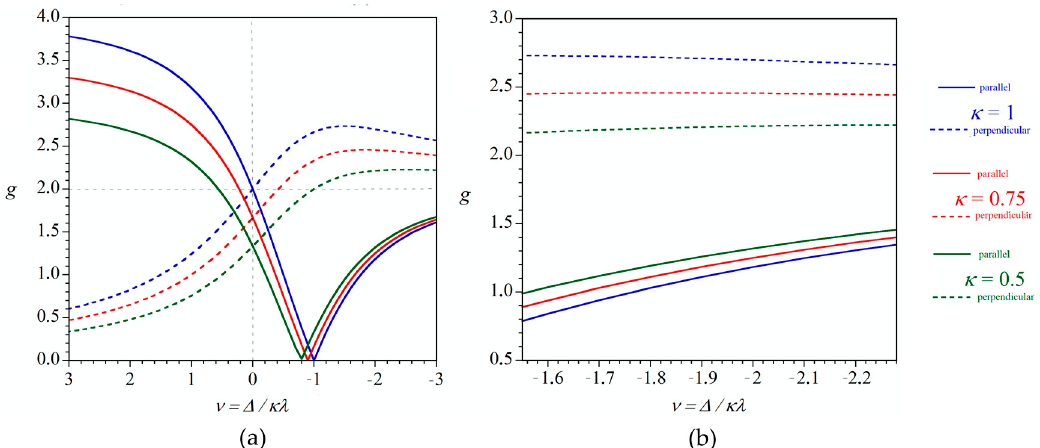
Figure 7. ( a ) Calculated values of the g factor for an electronic configuration t 25 ( λ < 0) as a function of possible negative and positive values of the distortion factor ( ν ) under different values of the covalence factor ( κ ). ( b ) Details of the calculated values of the g factor for λ = –2000 cm − 1 and κ = 0.5 − 0.75.